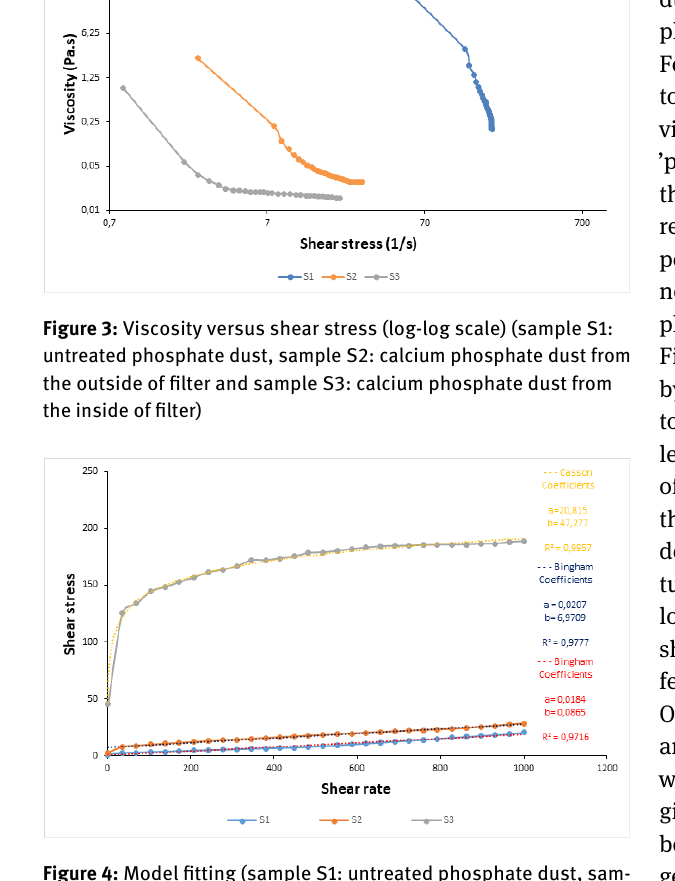
Figure 4: Model fitting (sample S1: untreated phosphate dust, sam- ple S2: calcium phosphate dust from the outside of filter and sam- ple S3: calcium phosphate dust from the inside of